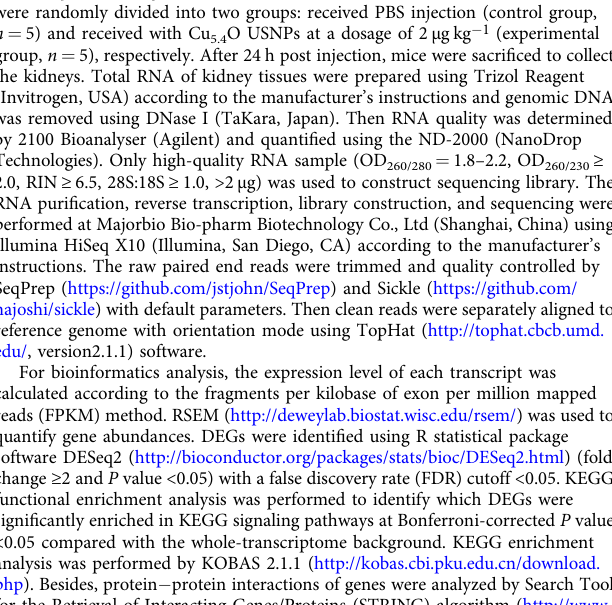
Table 2. The total proteins from kidney tissue were extracted using ice-cold RIPA lysis buffer containing phosphatase and protease inhibitor cocktail (KeyGEN, China). The concentrations of extracted proteins were determined using a BCA protein assay kit (Thermo Scienti fi c, USA). An equal amount of protein from each sample was run in 8% SDS-PAGE gel, then transferred to polyvinylidenedi fl uoride (PVDF) membranes (Millipore, USA). PVDF membranes were blocked with 5% skim milk at room temperature for 2h and then incubated with primary antibodies at 4°C overnight, followed by incubation with secondary horseradish peroxidase- conjugated antibodies (1:1000, Sungene Biotech, China) for 1 h at room temperature. The intensity of bands was visualized and determined using a ChemiDoc ™ XRS detection system (Bio-Rad, USA). Primary antibodies used were: NF- κ B p65 (L8F6), phospho-NF- κ B p65 (Ser536, E1Z1T), I κ B- α (L35A5), phospho-I κ B- α (Ser32/36, 5A5) (1:1000, Cell Signaling Technology, USA) and β -actin (1:1000, Sungene Biotech, China). The primary images (Fig. S31)